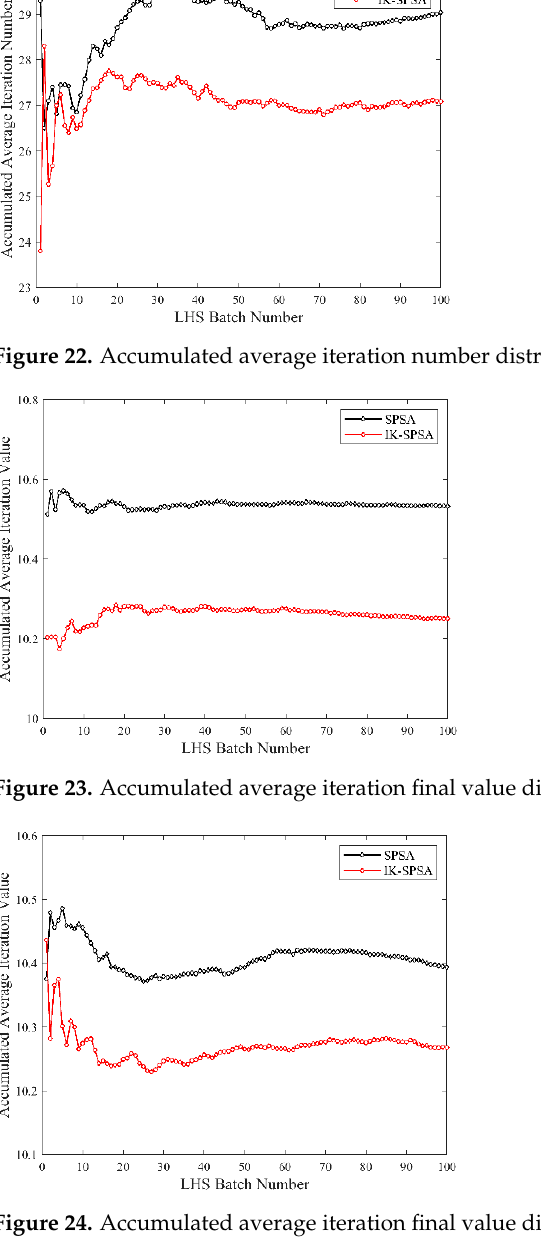
Figure 24. Accumulated average iteration final value distribution at different initial points.